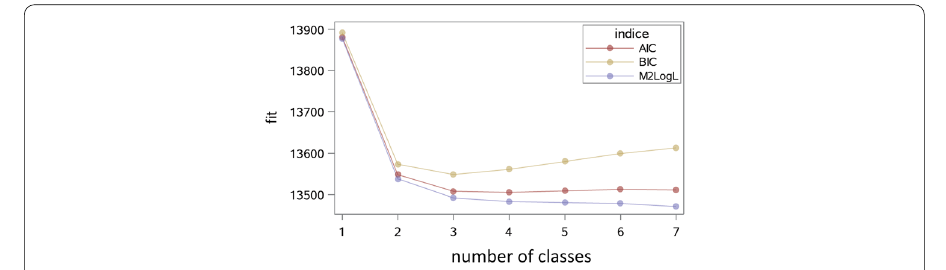
Fig. 3 Elbow plot of the class enumeration for item S131Q02 in cluster position 4